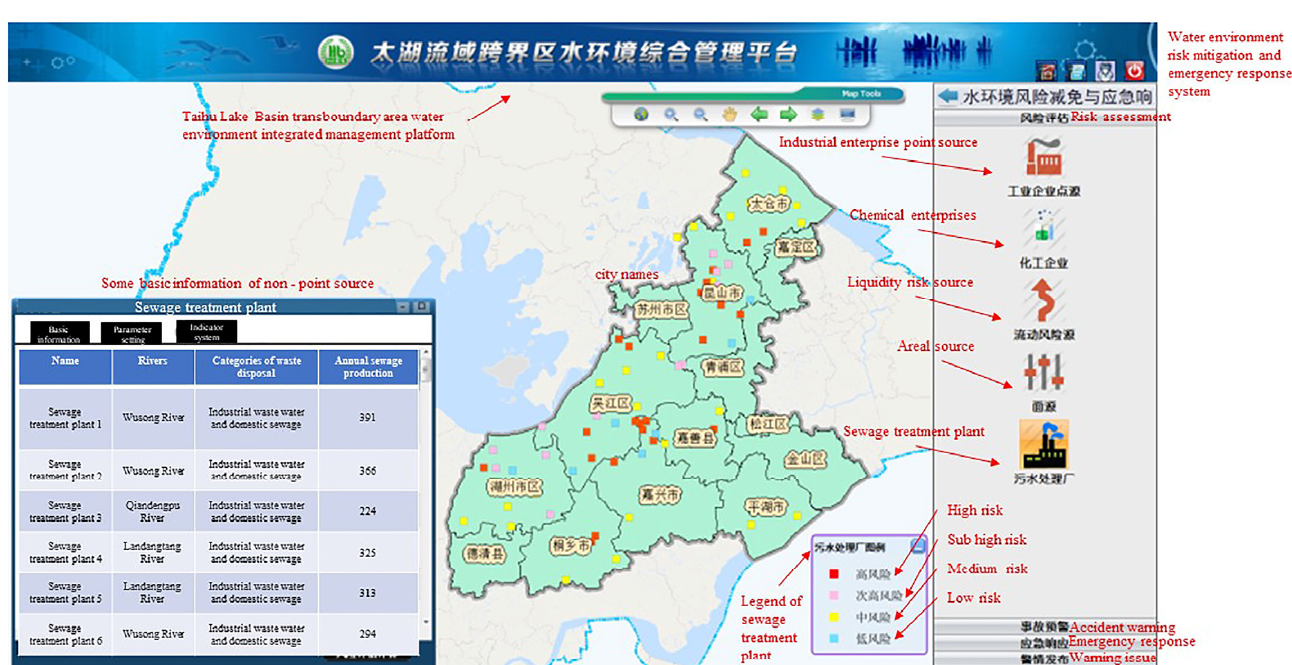
Figure 9. Risk assessment results for the sewage treatment plants.